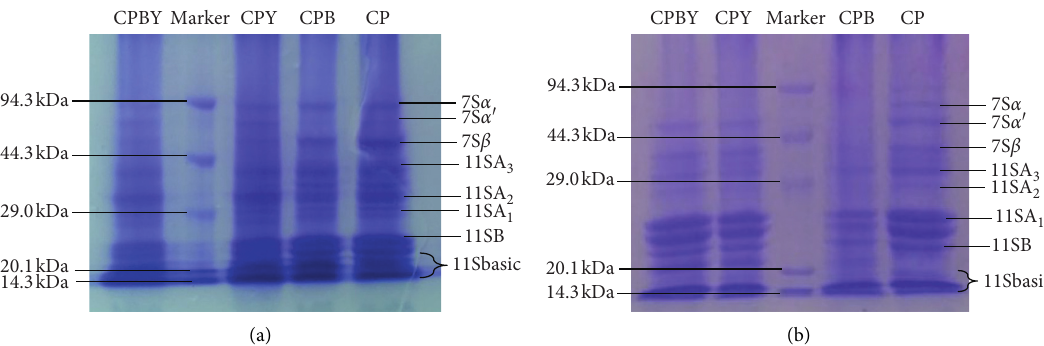
Figure 3: SDS-PAGE diagram of four samples at 0h (a) and 24h (b). CP, chickpea fermentation milk; CPB, chickpea fermentation milk with enzyme hydrolysis; CPY, chickpea yam fermentation milk; CPBY, chickpea yam fermentation milk with enzyme